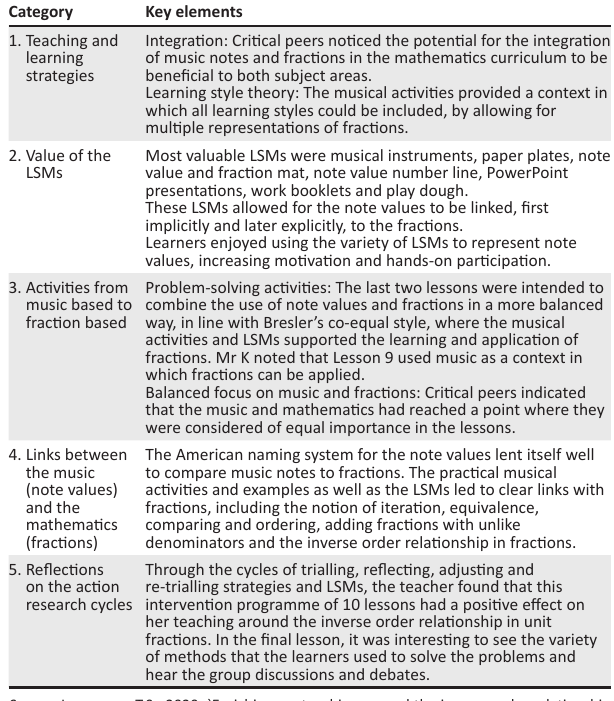
TABLE 3: The five categories of findings and key